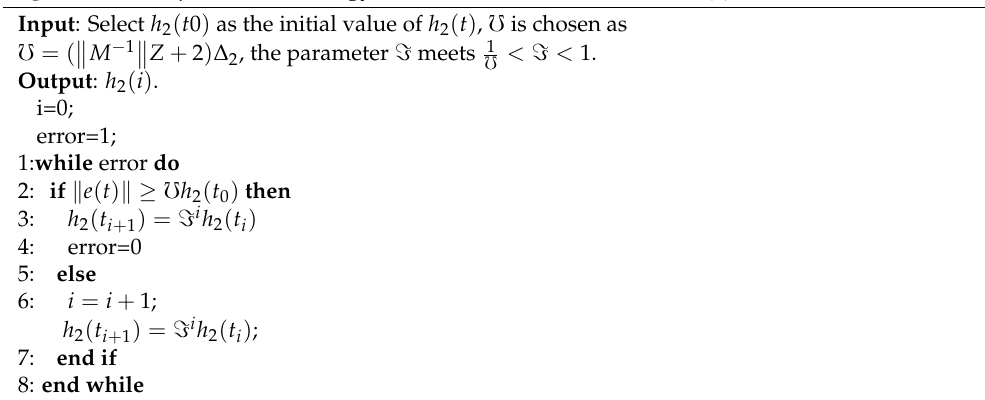
Algorithm 2 Adjustment Strategy of Quantization Parameter h 2 ( t )